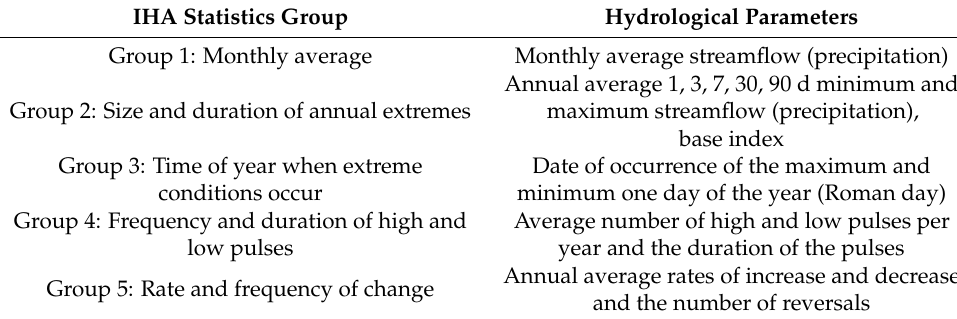
Table 1. Summary of hydrological parameters used in the